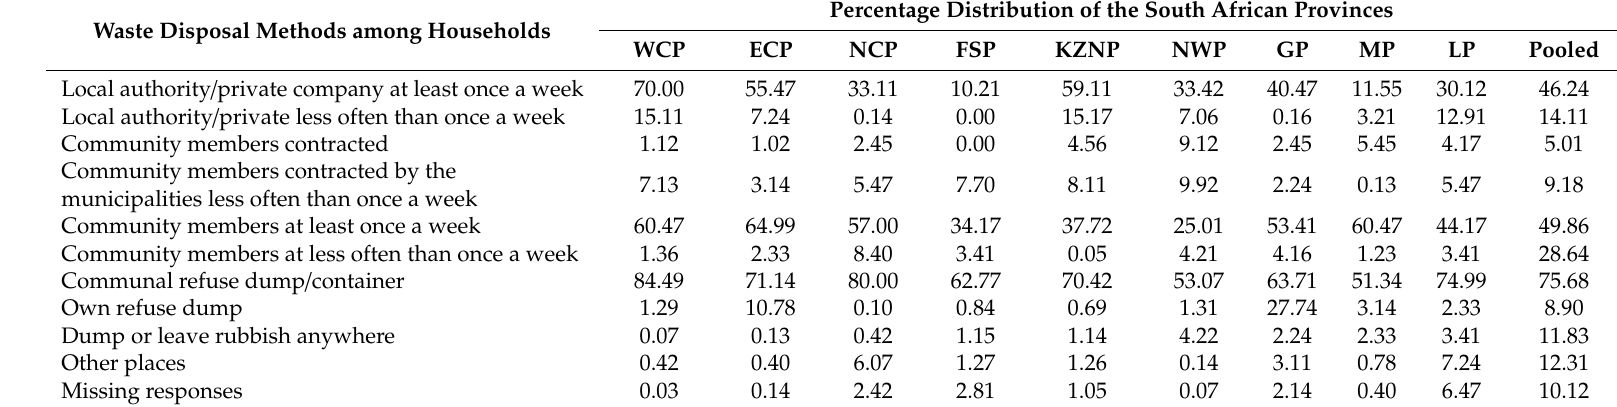
Table 2. Percentage distribution based on waste disposal methods.